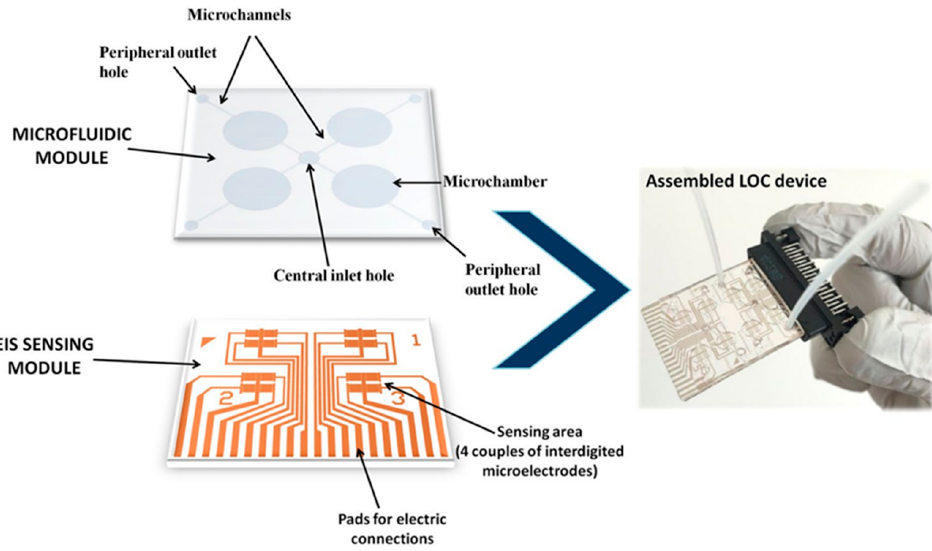
Figure 3. Description of the lab-on-a-chip device for the detection of Xylella fastidiosa made up of a sensing and a microfluidic module [217] with permissions. a sensing and a microfluidic module [217] with